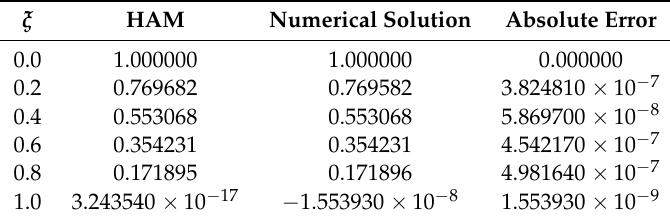
Table 3. Comparision of HAM and Numerical results for f ( ξ ) .